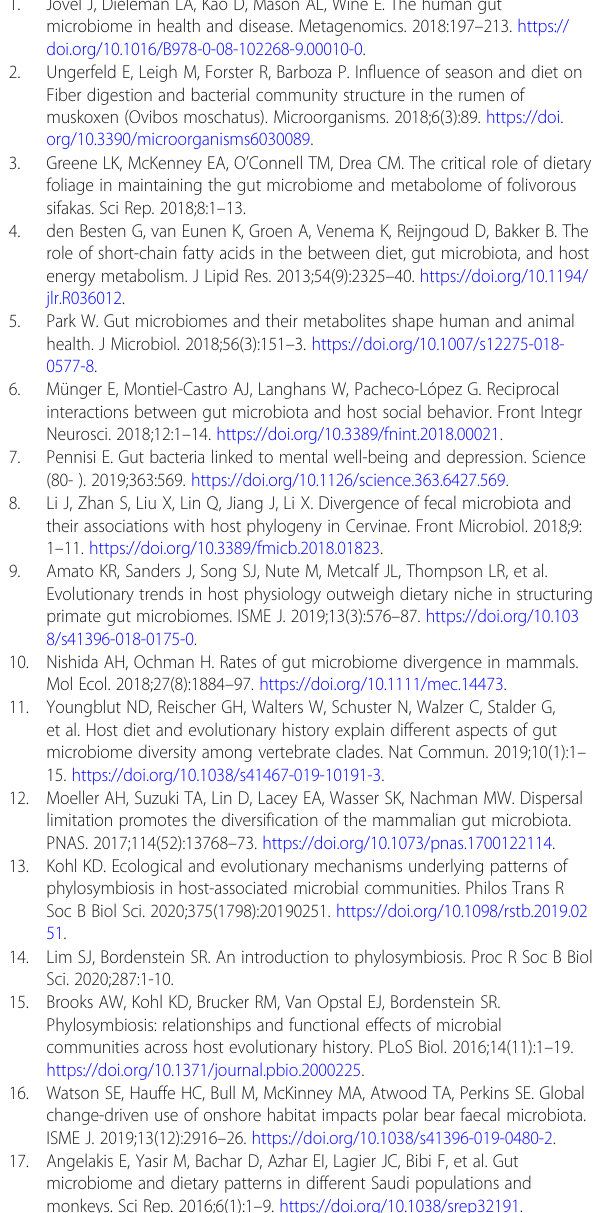
Additional file 1: Tables S1-S8. Table S1. Previously published dietary %C4 data for the surveyed herbivores. Table S2. PERMANOVA tests that include sample month, host dietary guild, and host species using the entire dataset (11 sp). Table S3-S6. Multiple-comparison testing of gut microbiota alpha-diversity among host families, species, and dietary guilds. Table S4. Previously published dietary %C4 data for the surveyed herbivores. Table S7. PERMANOVA tests that included sample month, geographic region, host dietary guild and host species for the combined Masai Mara and Laikipia dataset. Table S8. Partial correlation coefficient statistics regressing microbiota similarity against host phylogenetic re- latedness or diet. Table S9. Proportion of ASVs that were differentially enriched in herbivores from one geographic region compared to the other according to LEfSe. Table S10. Sample sizes for each month for the combined Masai Mara and Laikipia dataset (.xlxs 29KB). Additional file 2: Figs. S1-S6. Fig. S1-S2. Stacked bar plots showing relative abundances of top bacterial phyla and genera. Fig. S3. Heatmap of the relative abundances of 10 widely-shared bacterial ASVs. Fig. S4. Stacked barplot of the proportion of samples from each host species